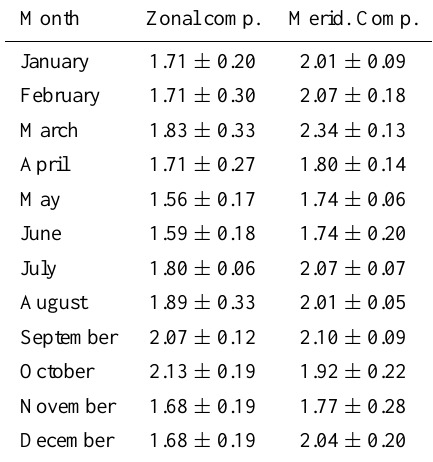
Table 2. Phase of 12-h oscillation (LT). Month Zonal comp. Merid.